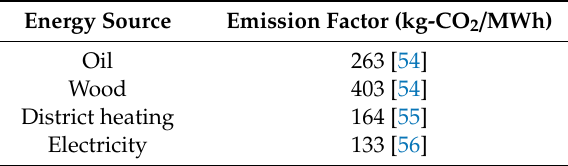
Table 6. Emission factors of energy